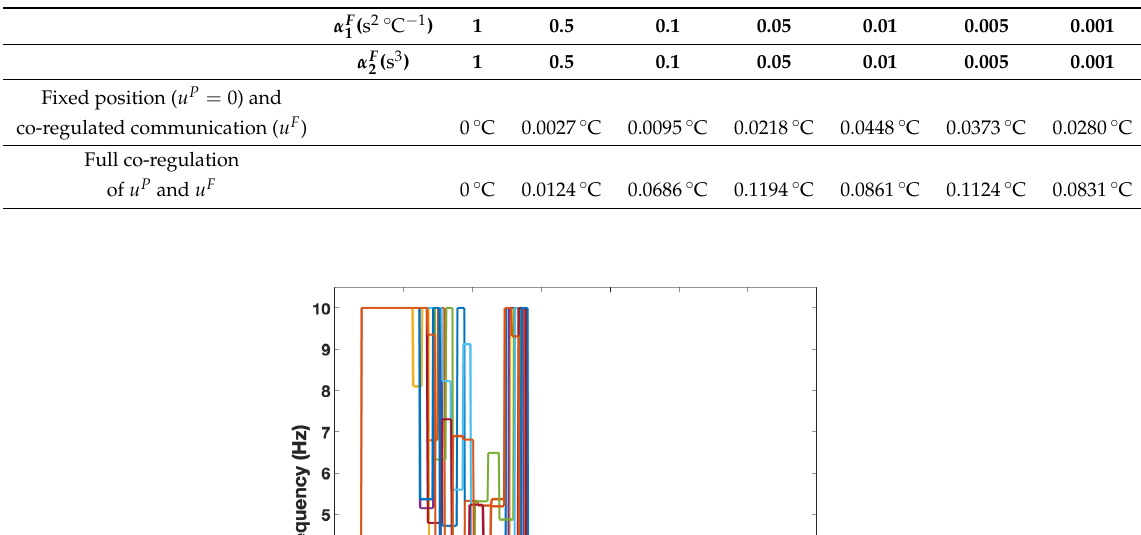
Table 6. Error between the converged value and the true mean of the initial conditions with varying α 1 and α 2 .